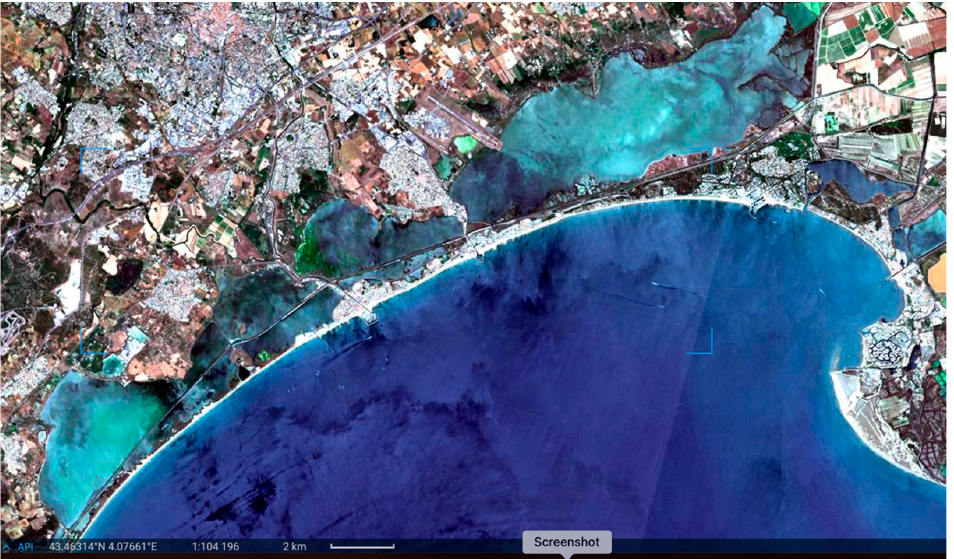
Figure 2. Dystrophies in non-tidal lagoons of the Montpellier department (France). The slight green colouration is a development of Cyanobacteria; the lactescence is due to colloidal sulfur. Sentinel-2 image of 1 July 2022.